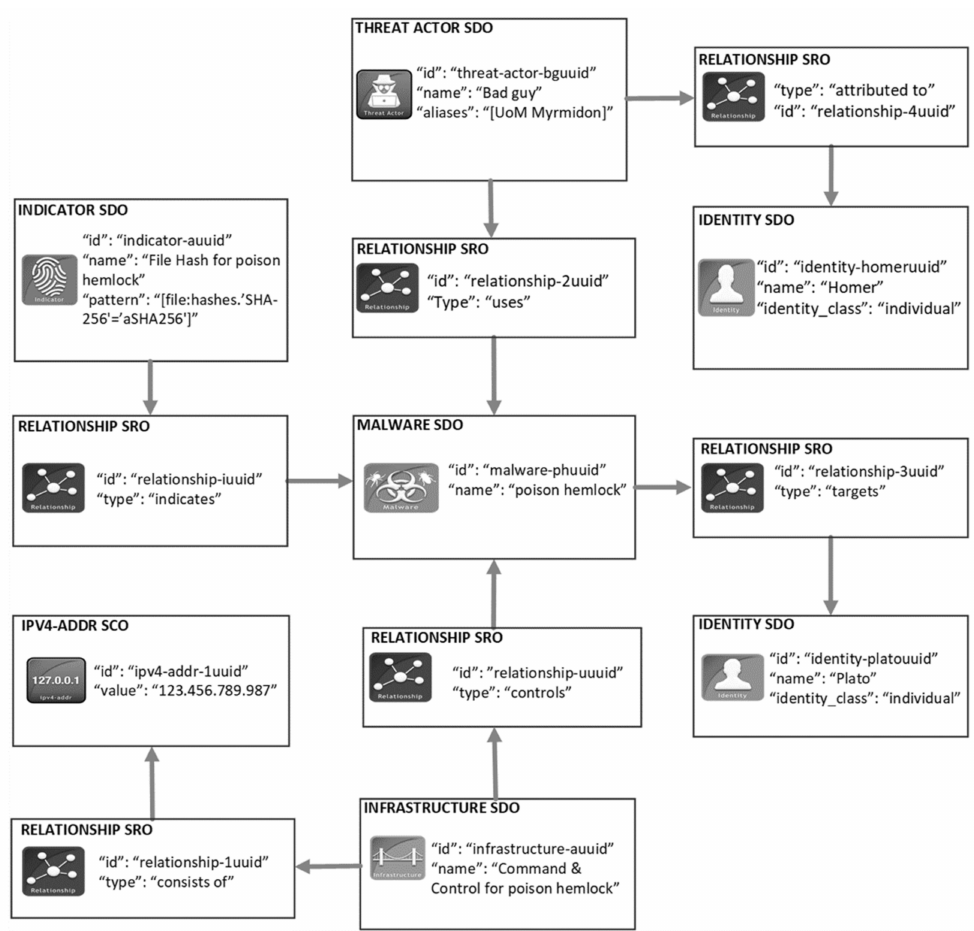
Figure 1. A graphical representation of a cyber threat information product in the STIX language. As already mentioned, a Sighting SRO allows organizations to communicate back to the CTIP sharing community that an SDO or SCO of a CTIP was also seen in their environments. According to OASIS, it is vital for the community to be aware that an SDO or SCO of a CTIP was also spotted elsewhere [30]. Figure 2 depicts an example of a Sighting SRO that relates to the Indicator SDO of Figure 1. This Sighting SRO communicates that the Indicator SDO of the above example was spotted in the environment of